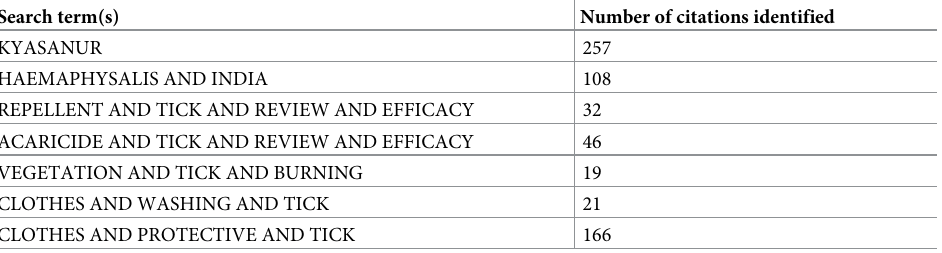
Table 1. Search terms used to identify literature in Web of Science and PubMed providing empirical evidence for disease ecology and transmission of KFD and for the effectiveness of current management